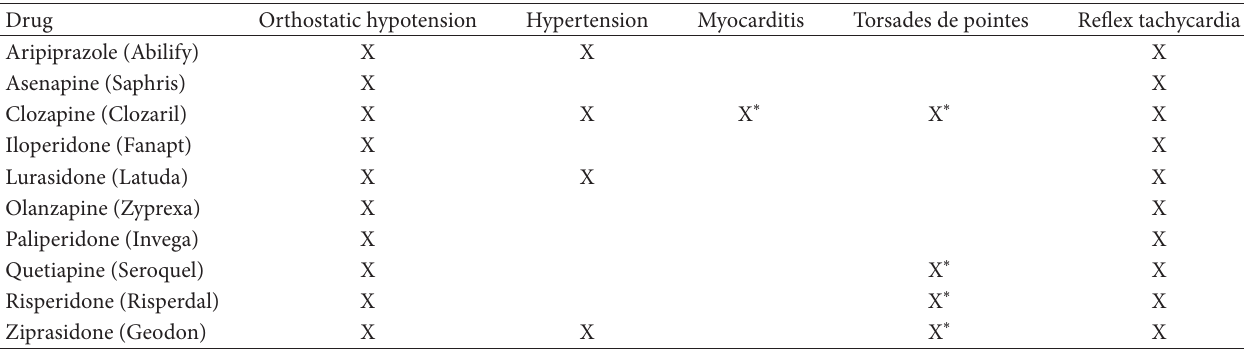
Table 1: Cardiovascular side effects of second generation